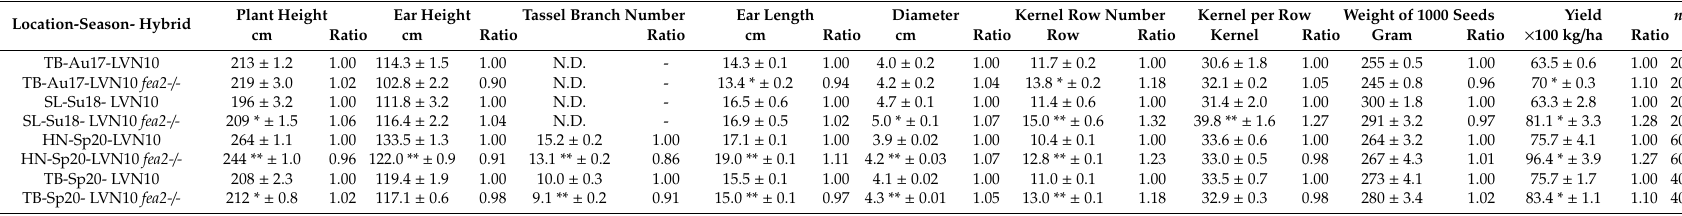
Table 2. Measurements of agronomic traits and yield of introgressed hybrid (LVN10 fea2 - / -) and the original hybrids (LVN10) in multiple locations and seasons. Location-Season- Hybrid Plant Height Ear Height Tassel Branch